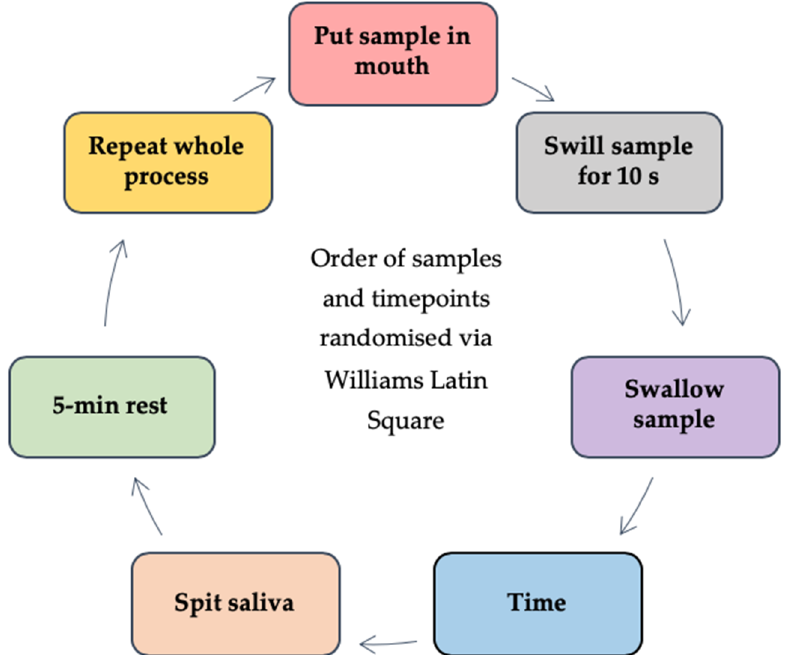
Figure 3. Brief overview of saliva samples post beverage consumption protocol. Volunteers were provided with verbal and written instructions as to the protocol and given the opportunity to ask questions. Volunteers were provided with one 10 mL sample and asked to swill the sample around in their mouth for 10 s before swallowing. After this a randomised countdown clock (time; either 15 s, 30 s, 60 s or 120 s) was started and once it reached zero, volunteers gave a saliva sample into wide lid collection tube (60 mL). A 5-min rest period followed, with the procedure being repeated for the seven remaining samples and timepoints.